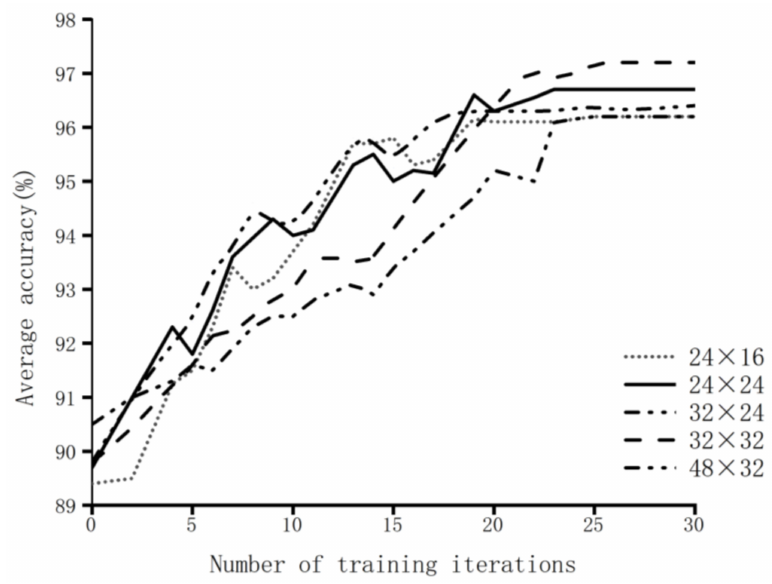
Figure 10. The relationship between the size of the clipping sample and the average accuracy of CNN